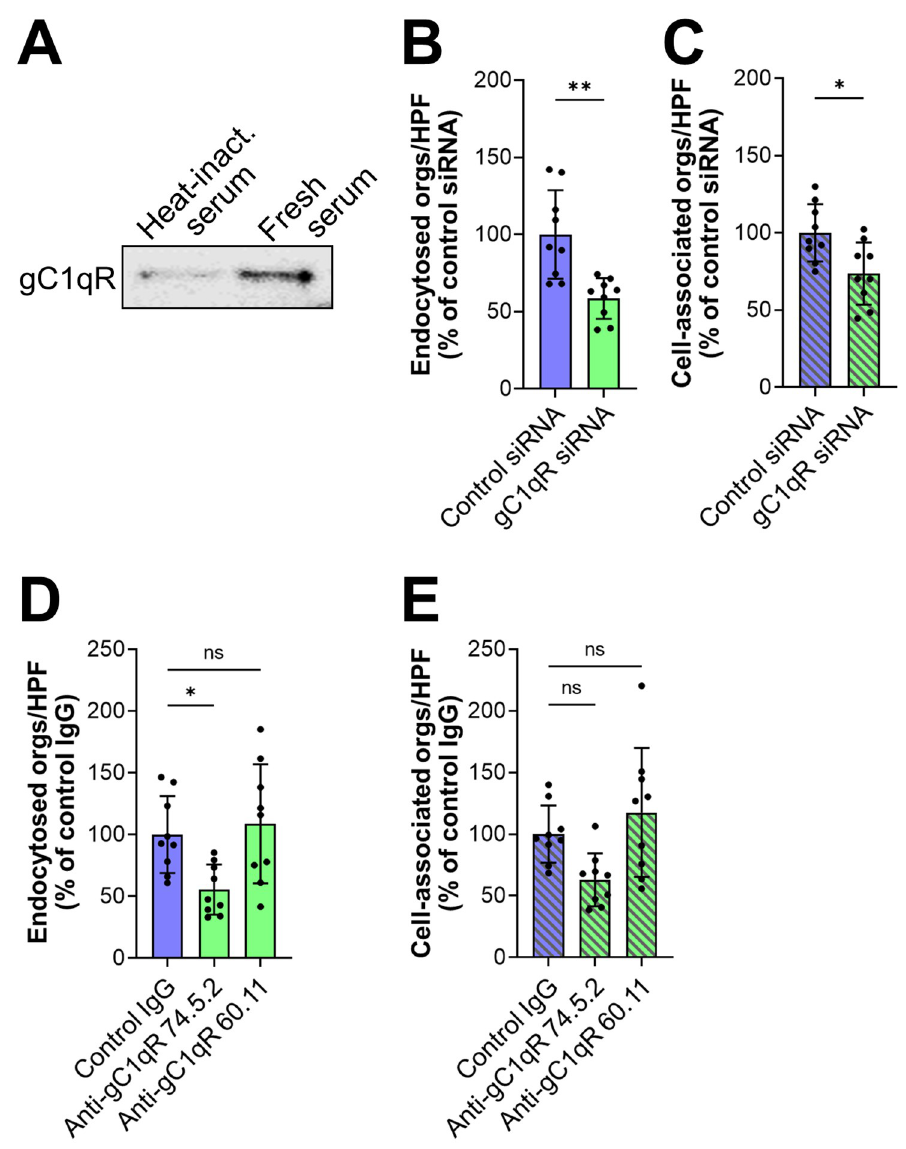
Fig 2. The globular C1q receptor (gC1qR) is a human endothelial cell receptor for serum-coated C . glabrata . (A) Western blot showing that endothelial cell gC1qR binds to C . glabrata coated with fresh serum. Results are representative of 3 independent experiments. (B-E) Effects of inhibiting gC1qR function with siRNA knockdown (B and C) and specific monoclonal antibodies (D and E) on the endocytosis (B and D) and cell-association (C and E) of C . glabrata coated with fresh serum. Antibody 74.5.2 recognizes the high molecular weight kininogen binding site in the C-terminus of the gC1qR and antibody 60.11 is directed against the C1q binding site in the N-terminus of the gC1qR. Results shown in (B-E) are the mean ± SD of 3 experiments each performed in triplicate. Heat inact., heat inactivated serum; orgs/HPF, organisms per high-power field; ns, not significant, � P < 0.05, �� P < 0.01 by Student’s t-test (B and C) or ANOVA with the Dunnett’s test for multiple comparisons (D and